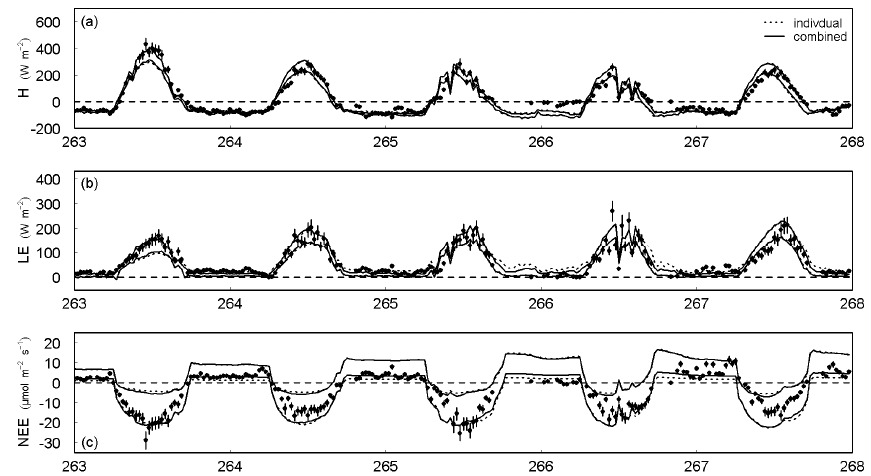
Fig. 7. Predictive uncertainty bounds (5th and 95th quantile) and observed values (black dots) for the sensible heat flux, H, (a) , the latent heat flux, LE, (b) , and the net ecosystem exchange, NEE, (c) , for the coefficient of efficiency (IOP-1, dotted lines: individual best 10%, solid lines: combined). Vertical lines display the error after Mauder et al. (2006) depending on the quality flag. For sensible heat fluxes, the error is 10% for quality classes 1-3 and 15% for quality classes 4-6. For latent heat fluxes and the NEE, the error is 15% for quality classes 1-3 and 20% for quality classes 4-6 according to Foken et al. (2004).